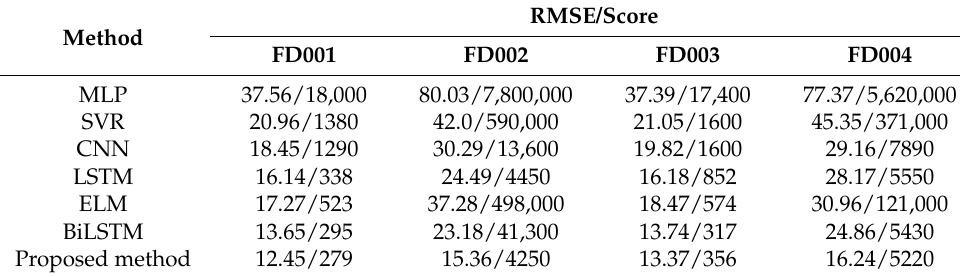
Table 2. Model performance comparison on the C-MAPSS